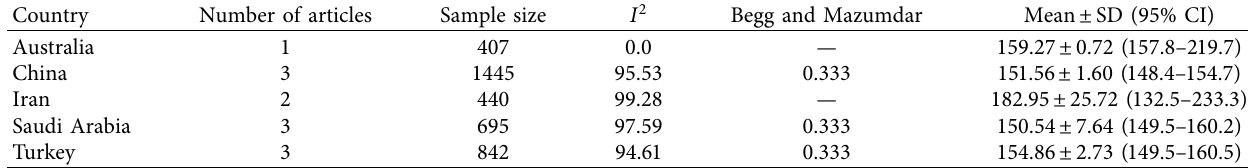
Table 2: Subgroup analysis on the country of study and mean of self-directed learning in nursing students. Country